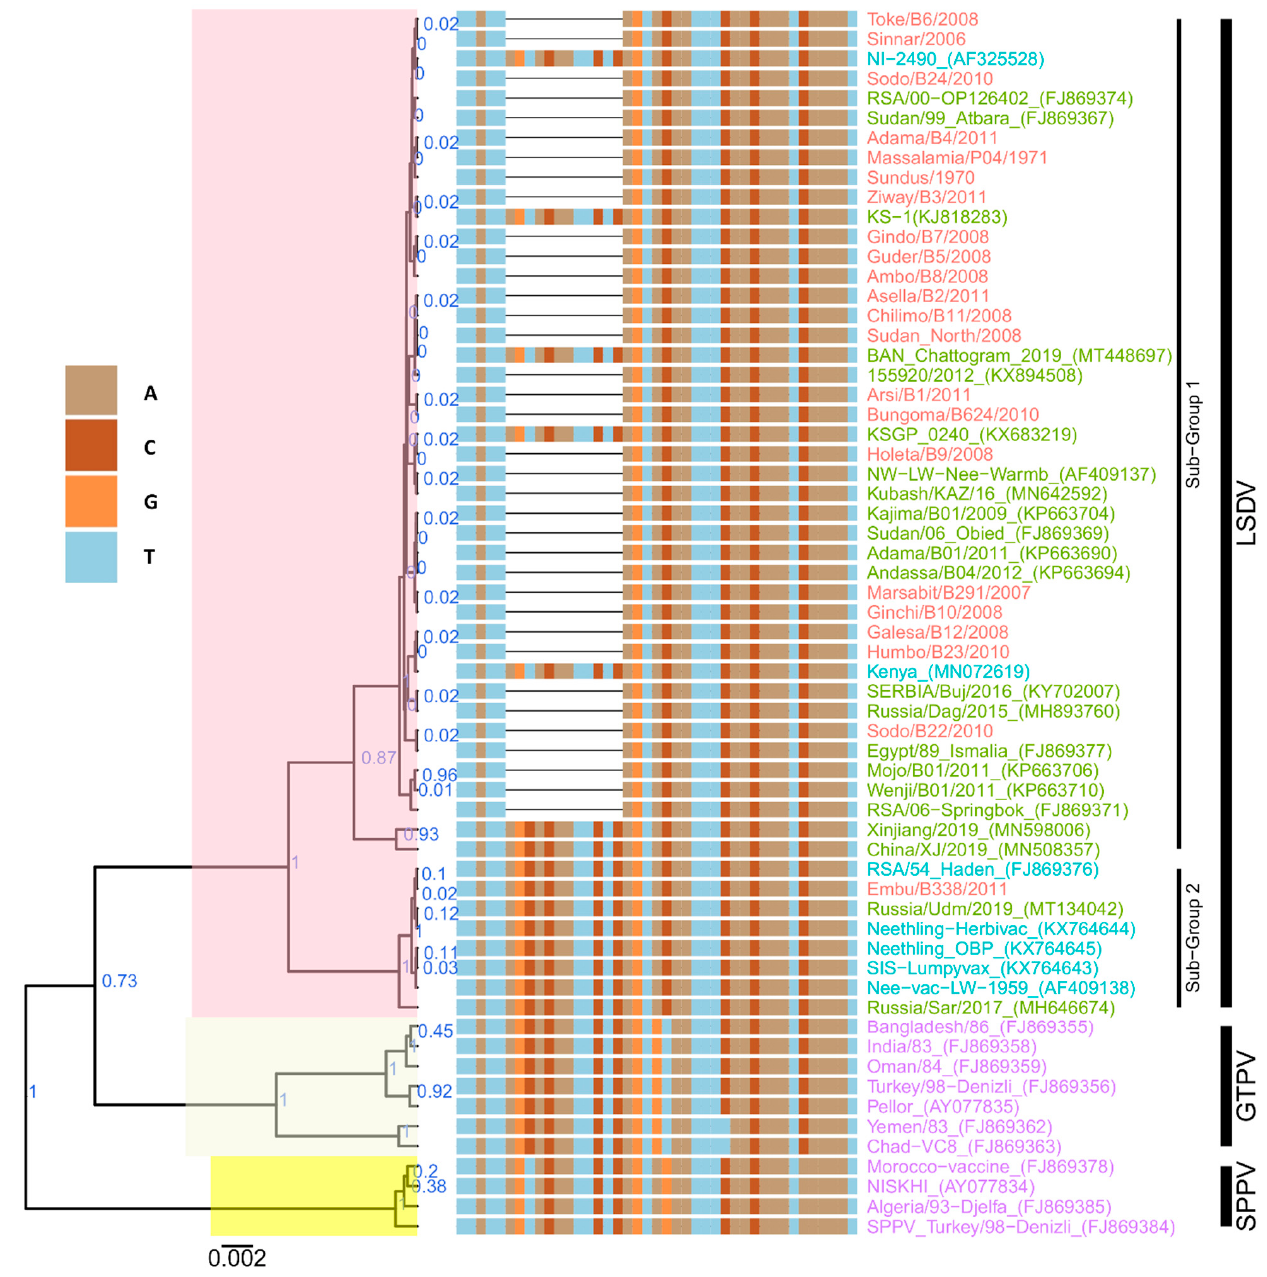
Figure 3. Maximum clade credibility (MCC) tree based on the complete GPCR gene sequences of capripoxviruses, plotted together with multiple sequence alignment. Only the portion of the alignment between positions 80 and 120 is shown. The posterior probabilities are plotted as respective node labels. Study sequences are highlighted in red and reference sequences are represented with their accession numbers (blue for LSDVs collected before 1960 and green for those collected after 1960). SPPVs and GTPVs are shown in purple.